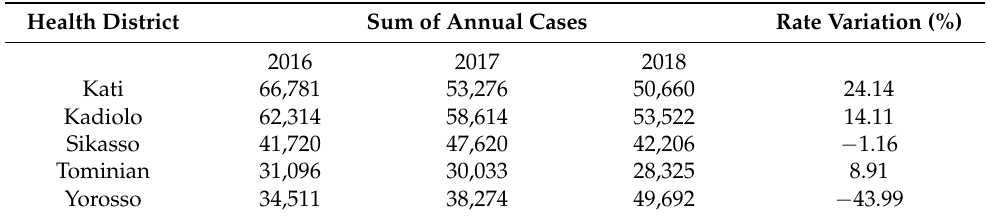
Table 2. Percentage change in incidence between 2016 and